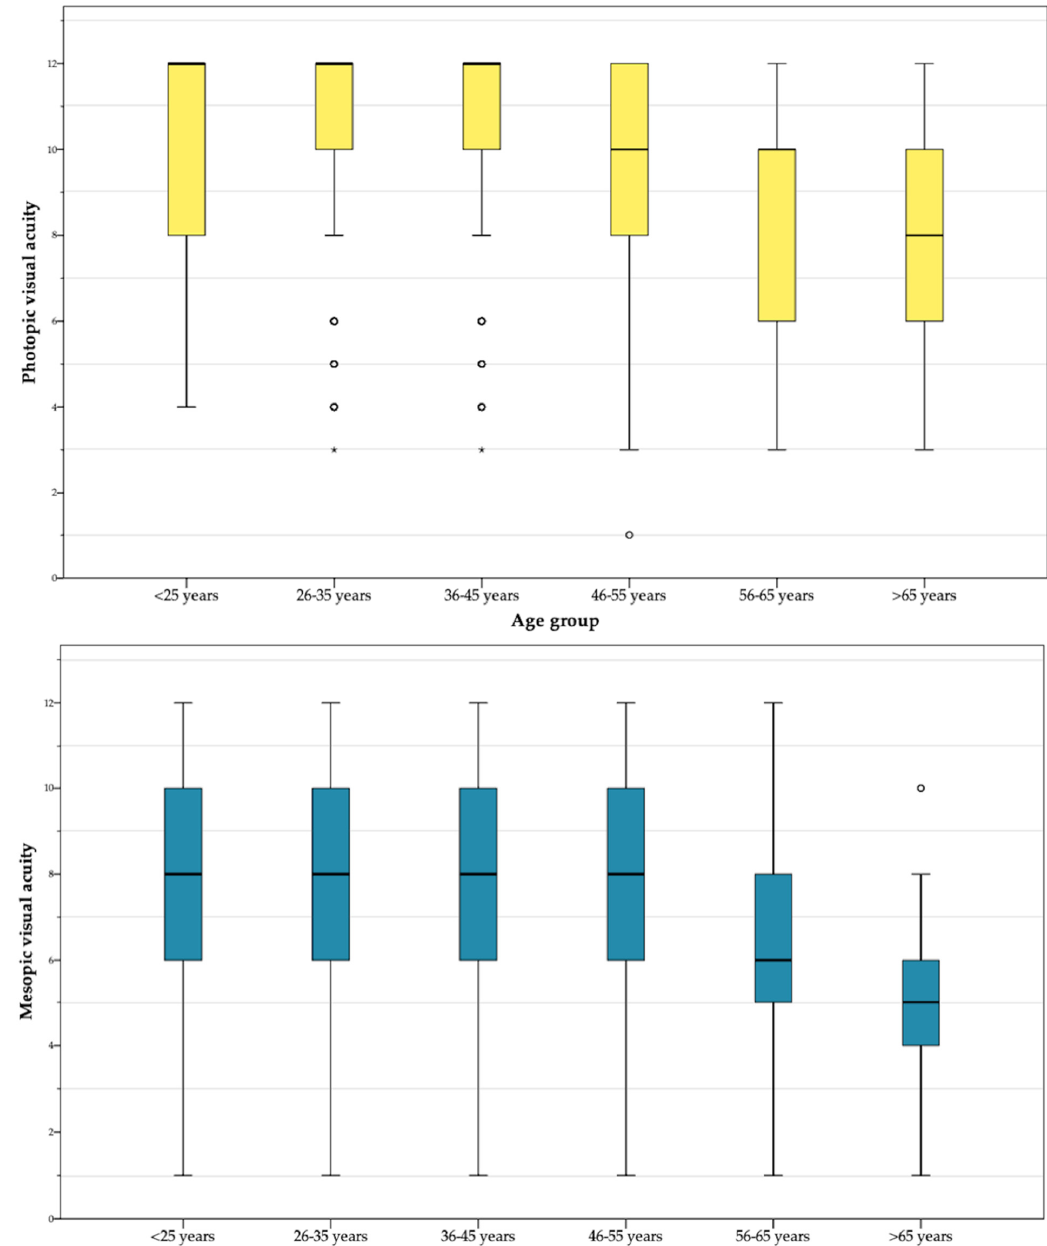
Figure 2. Boxplot-distribution of scores in photopic (high luminosity) and mesopic (low luminosity) visual acuity by age group (linear scale).